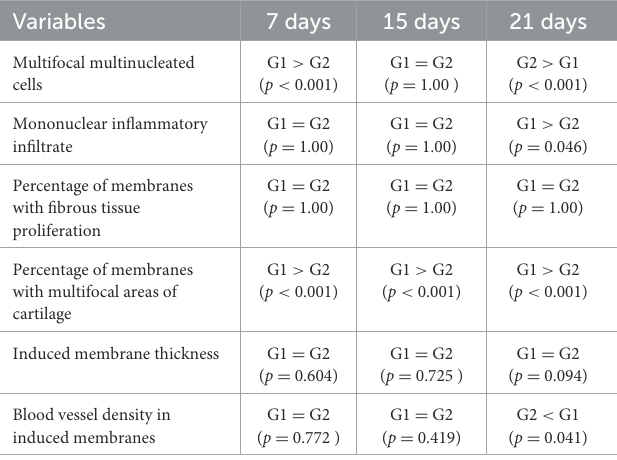
TABLE 1 Statistical comparison ∗ of histological findings of the induced membranes in Group 1 (bone defect filled with bone cement) and Group 2 (bone defect filled with cefazolin powder-loaded bone cement) at seven, 15, and 21 postoperative days. Variables 7 days 15 days 21 days Multifocal multinucleated G1 > G2 cells ( p < 0.001)